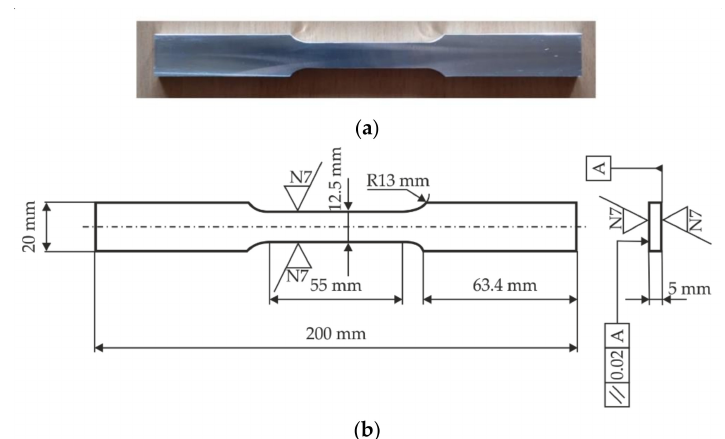
Figure 2. Shape ( a ) and dimensions ( b ) of the AA5083